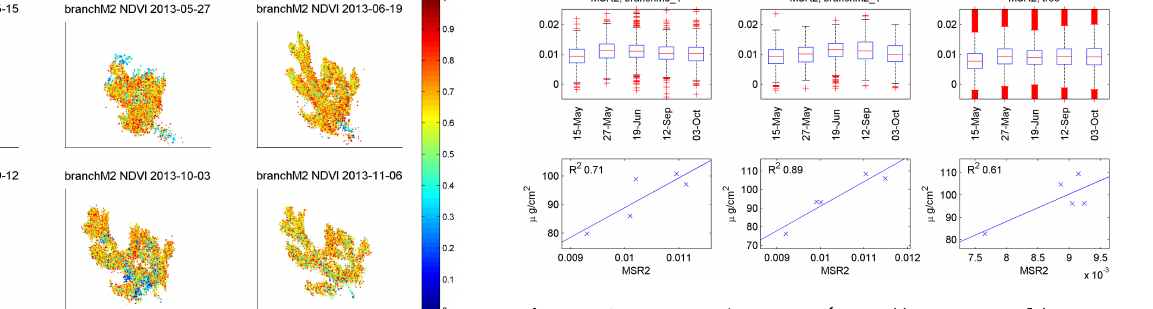
Figure 4. Same as previous figure (top and bottom rows; laboratory data are the same as in previous figure) but this time using the MSR2 spectral index.